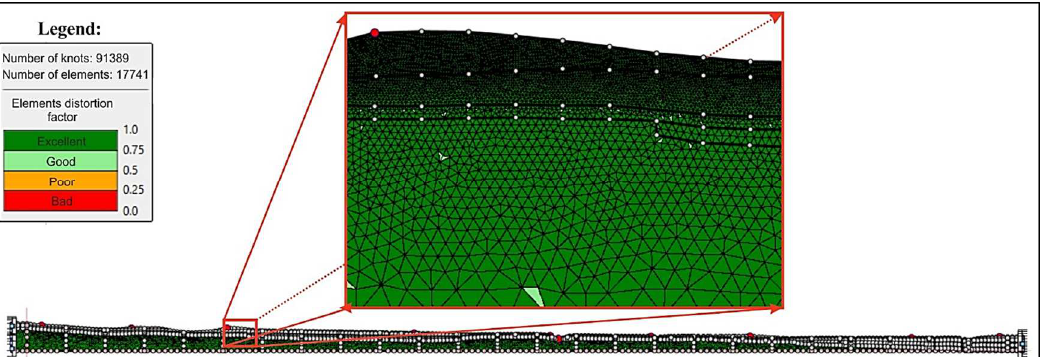
Figure 7. Mesh pattern, number of knots and elements of the 2D numerical model (AA’ section).